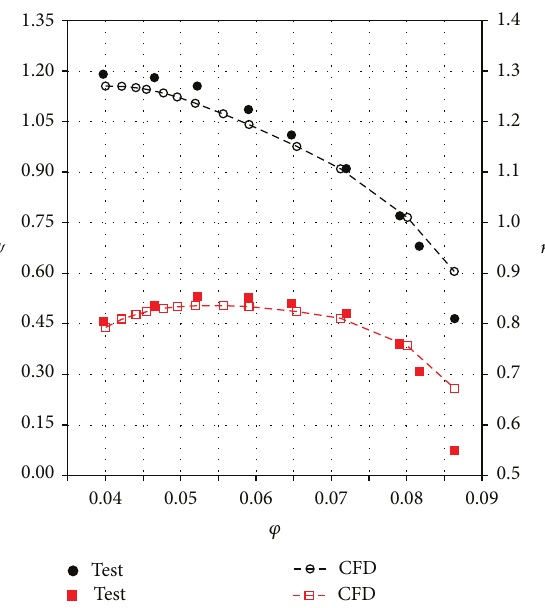
Figure 8: Performance comparison between test and